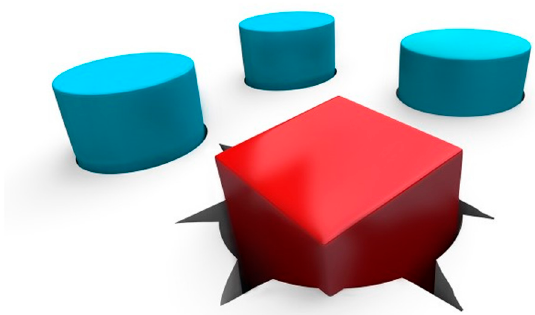
Figure 10. Picture showing the principle of trying to fit a square peg into a round hole; this applies to fitting a clubfoot that is not fully corrected into a foot abduction brace (to be avoided).